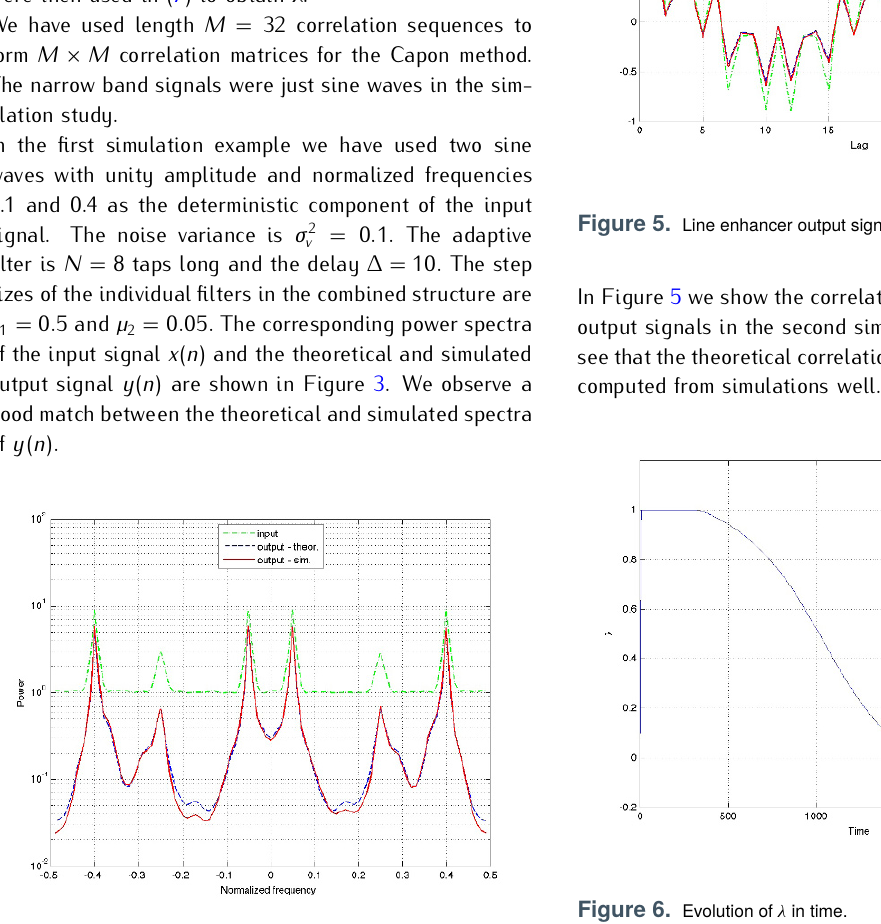
Figure 4. Line enhancer output signal spectrum.